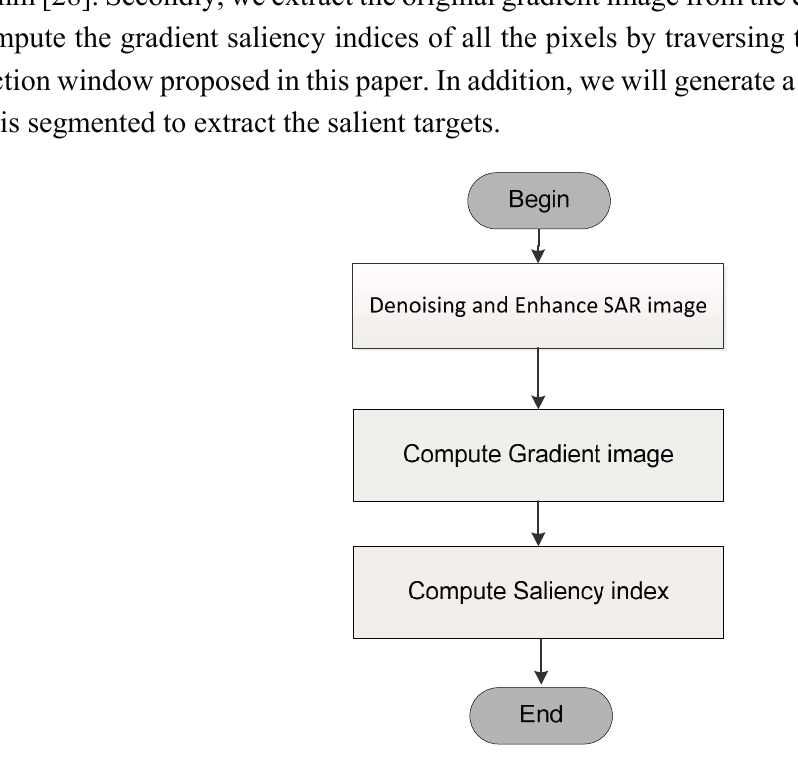
Figure 2. Salient target detection and textural saliency map generation based on directional local gradient